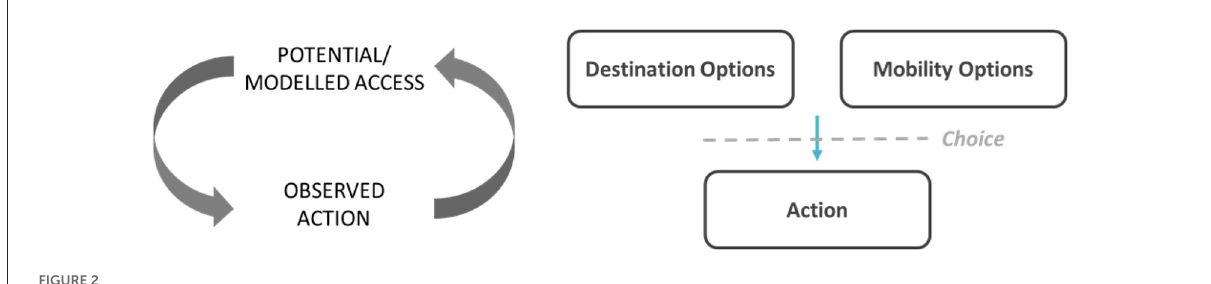
FIGURE2 Travel decision-making and the transport planning feedback loop.